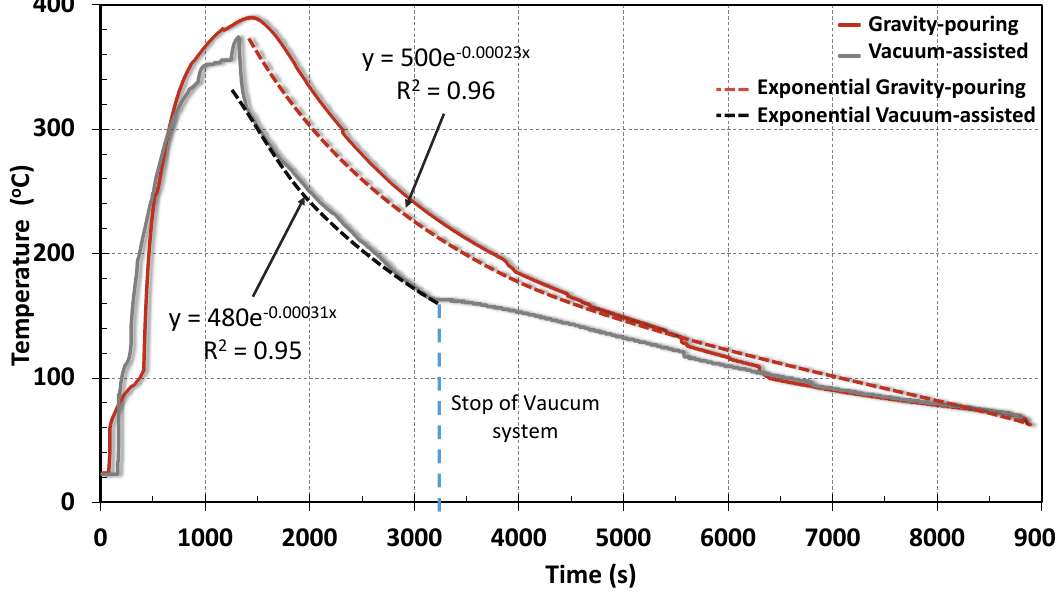
Figure 9. Temperature profile measured on the moulds after filling.